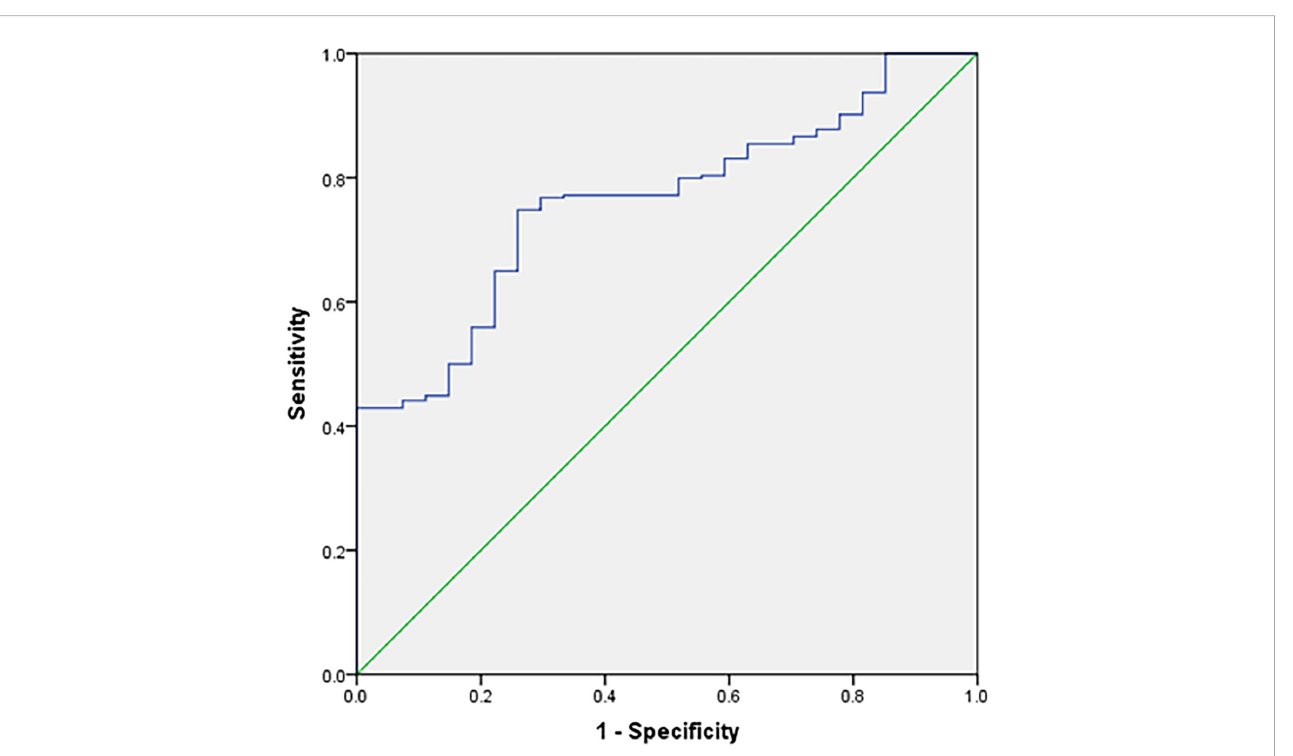
FIGURE 2 Receiver – operating characteristic (ROC) curve analysis for the monocyte-to-lymphocyte ratio as a predictor of Osteoporosis in postmenopausal females with T2DM (The sensitivity and speci fi city were 74.8% and 25.9%, respectively).